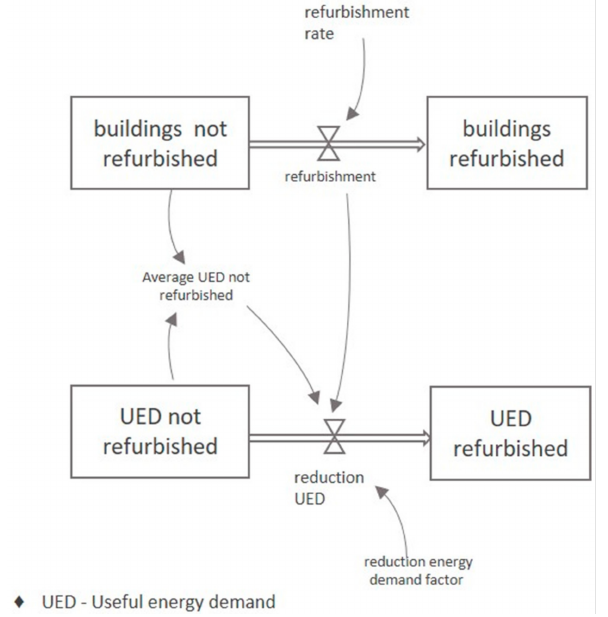
Figure 3. Aging chain co-flow structure of the demand side for building age class X and technology Y, derived from Schmidt et al.